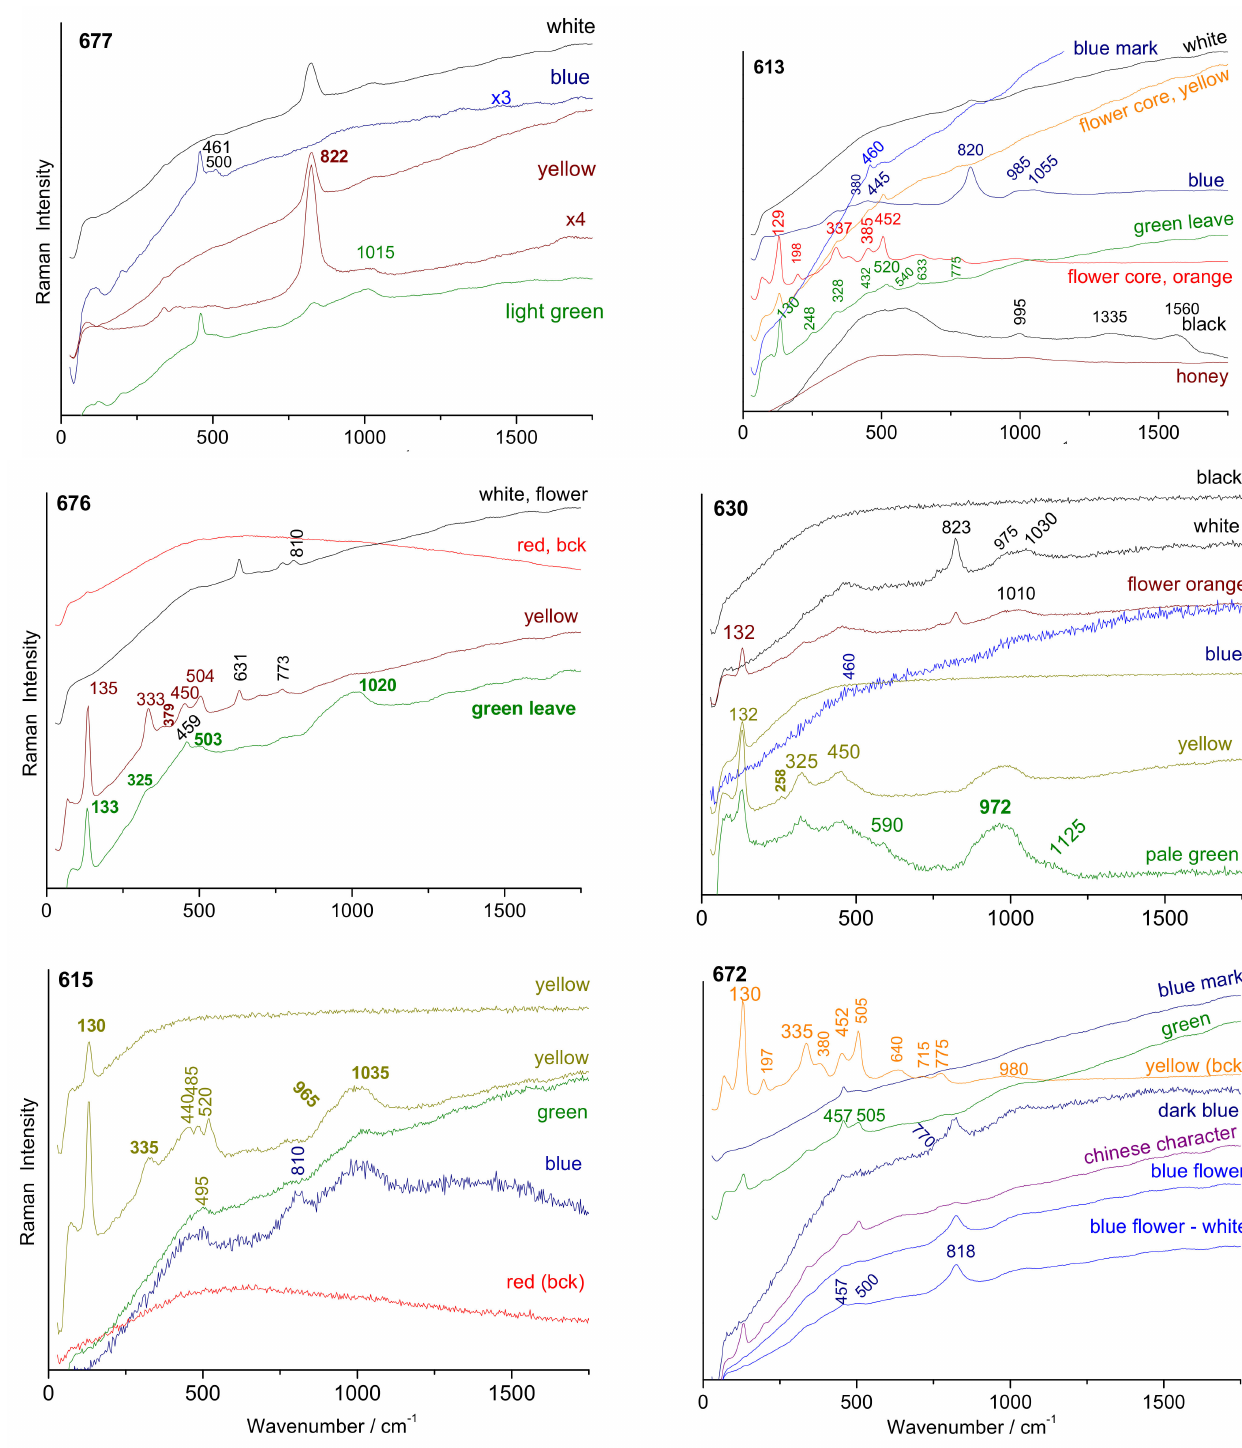
Figure 10. Comparison of representative Raman spectra for the different